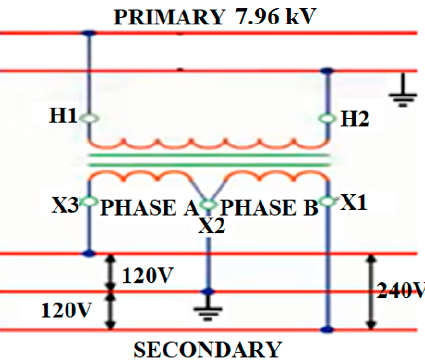
Figure 1. Single-phase transformer with central tap grounded.